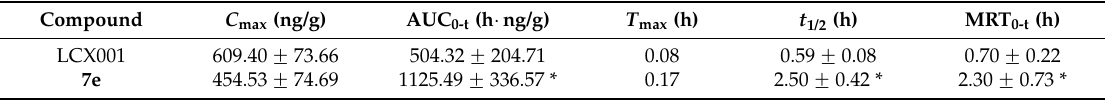
Figure 5. Concentration curve of LCX001 in brain versus time after administration of LCX001 and prodrug 7e . Error bars show the value of SD ( n = 3). Table 3. Pharmacokinetic parameters of LCX001 in brain after administration of LCX001 and prodrug 7e ( n = 3).